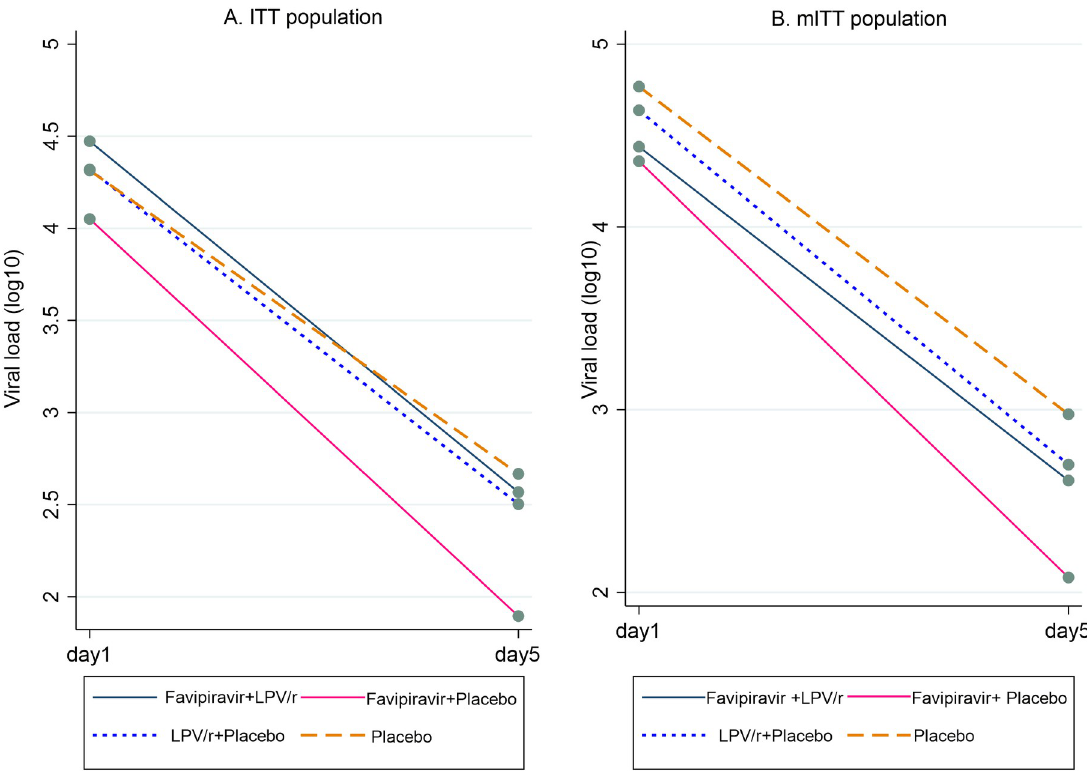
Fig 2. Mean log 10 SARS-CoV-2 viral load at baseline (Day 1) and Day 5 per treatment arm in (A) the full ITT population and (B) the mITT population, excluding participants with negative viral load at baseline and Day 5. ITT, intention-to-treat; LPV/r, lopinavir- ritonavir; mITT, modified intention-to-treat; SARS-CoV-2, Severe Acute Respiratory Syndrome Coronavirus 2.